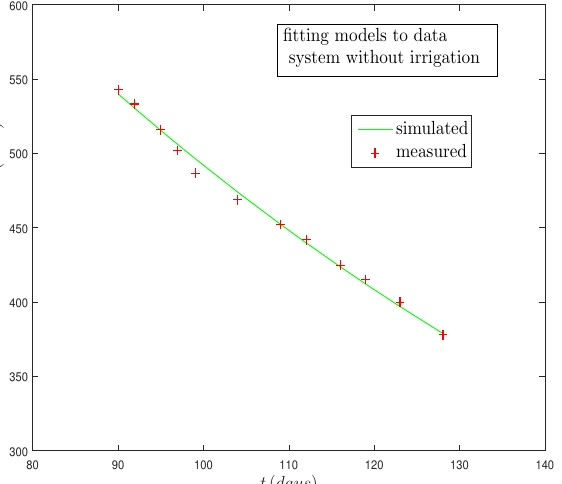
Figure 7. Model fit from the deficit irrigated wheat data (data extracted from Andarzian et al., [28].)